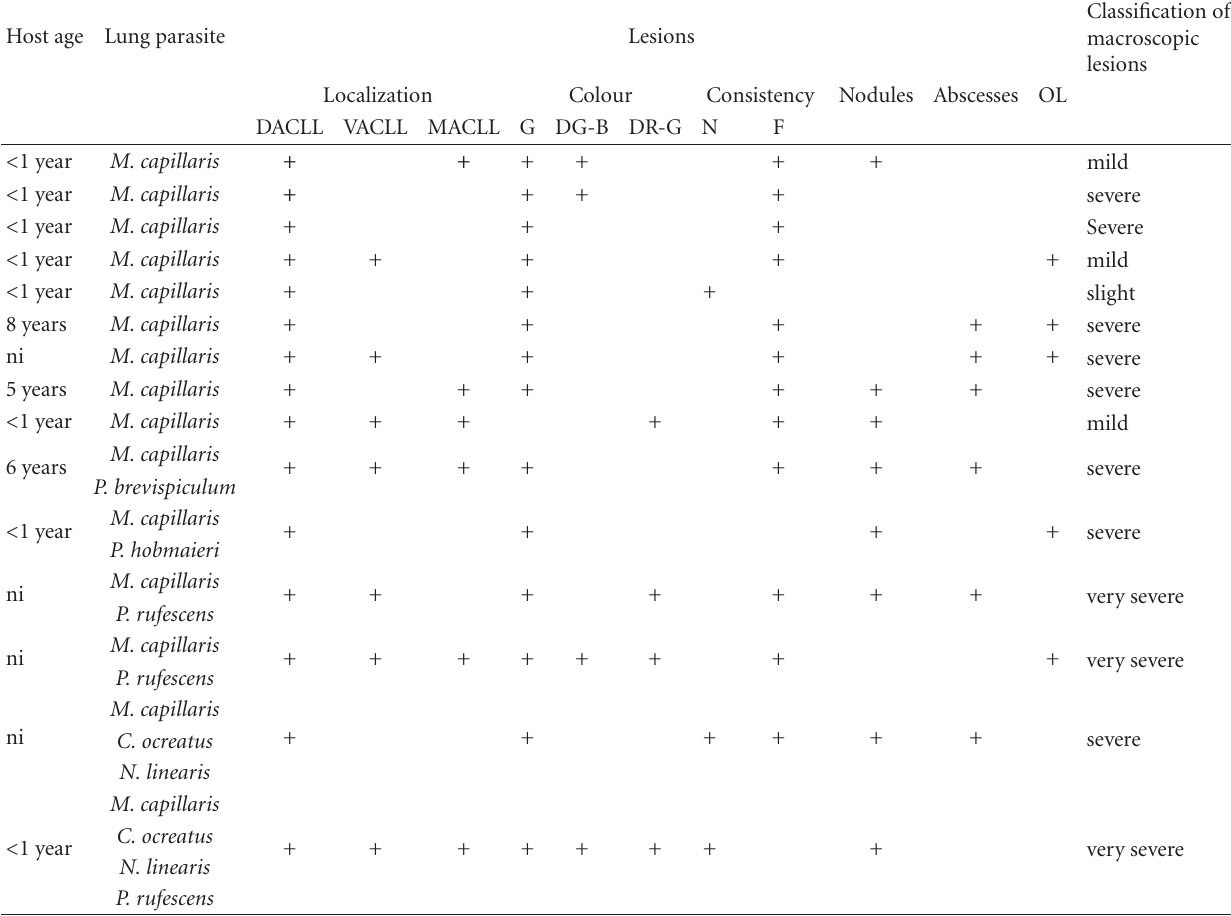
Table 2: Macroscopic lesions and classification of the lung change severity in sheep with natural protostrongylid